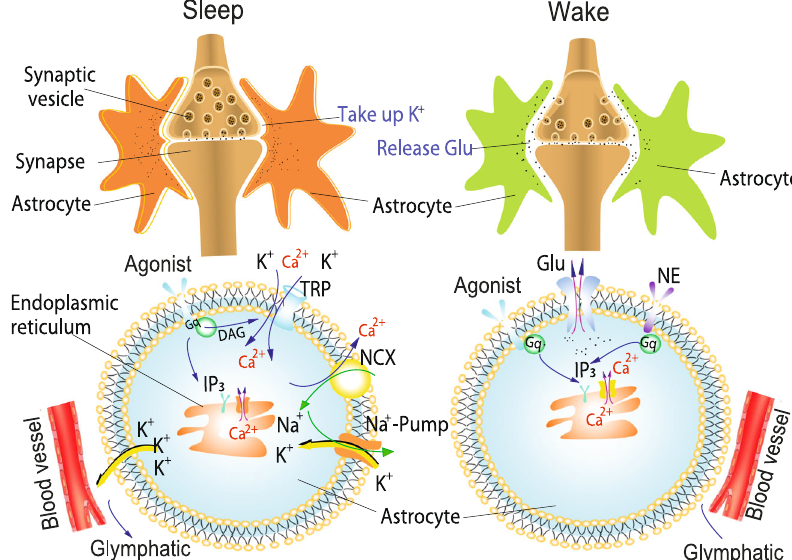
Fig.7|AmodelshowsthemechanismsofCa 2+ transientsaffectingEPSPsduring sleep and waking states. Left: During sleep, whisker stimulation induces gluta- mate release from neurons and activates mGluR (metabotropic glutamate recep- tor) and phospholipase C to release inositol trisphosphate (IP3) and diacylglycerol (DAG), which possibly open transient receptor potential ion channels (TRP chan- nels) to obtain Ca 2+ in fl ux into astrocytes. The Ca 2+ increase would in turn increase intracellular Na + , activating the Na + pump to take up K + and hyperpolarizing the